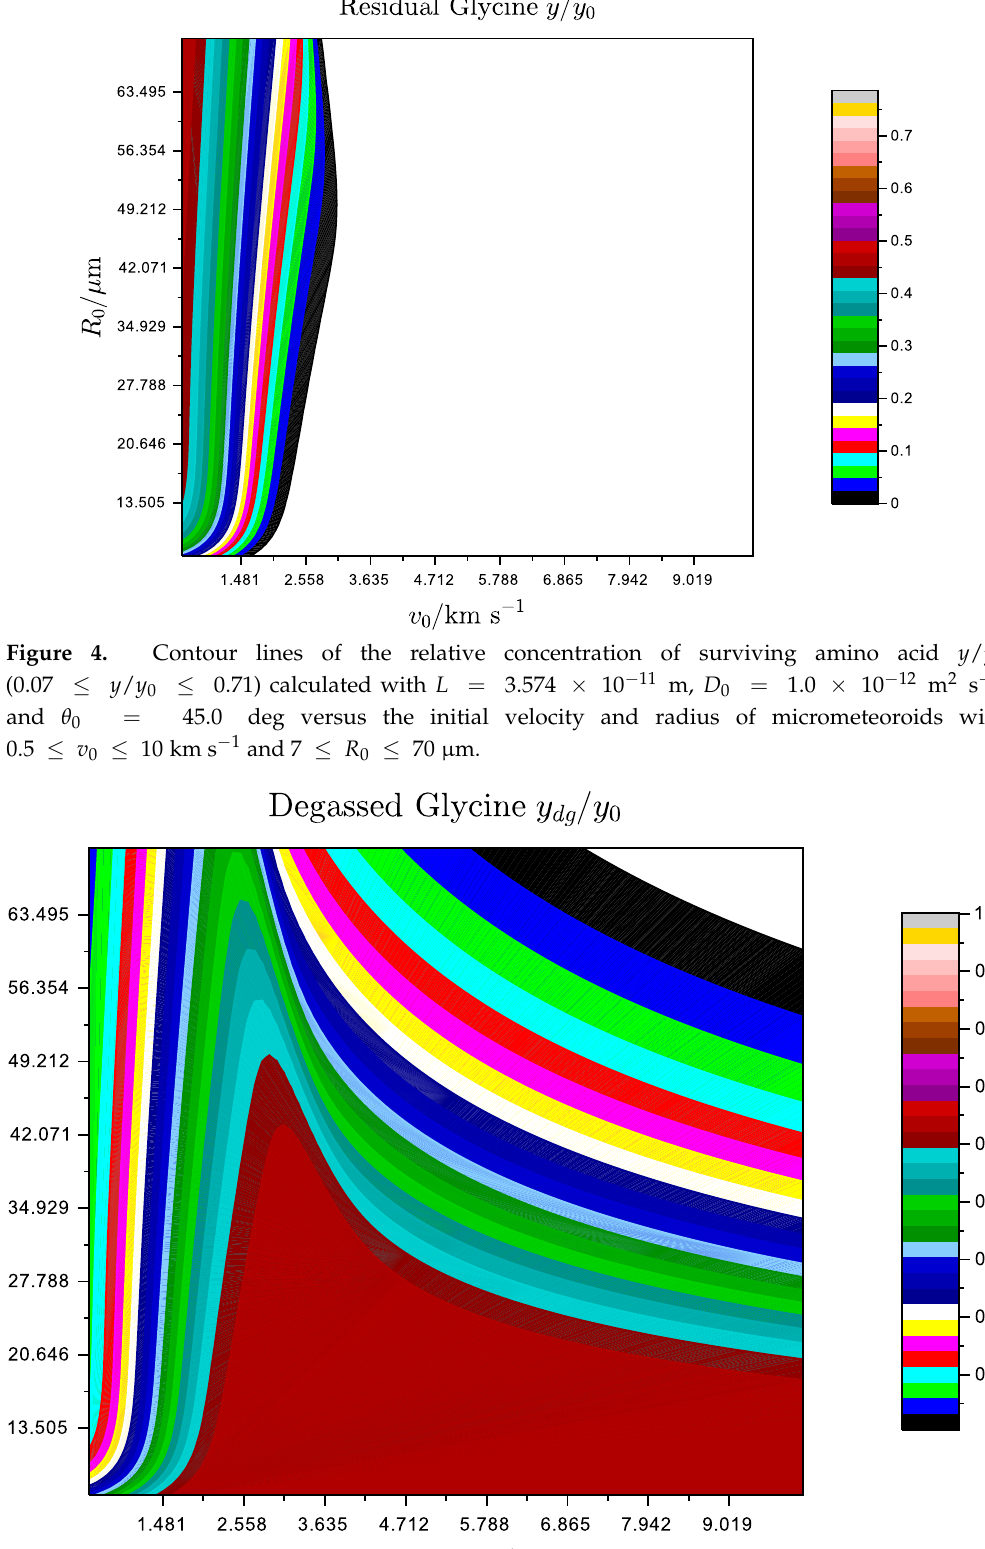
Figure 5. Contour lines of the relative fraction of degassed amino acid y dg / y 0 (0.19 ≤ y dg / y 0 ≤ 0.92) calculated with L = 3.574 × 10 − 11 m, D 0 = 1.0 × 10 − 12 m 2 s − 1 , and θ 0 = 45.0 deg versus the initial velocity and radius of micrometeoroids with 0.5 ≤ v 0 ≤ 10.0 km s − 1 and 7 ≤ R 0 ≤ 70 µ